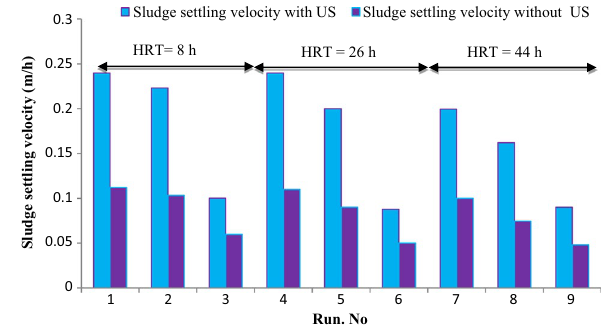
Fig. 8 Sludge settling velocity for the systems with and without US under different operating conditions